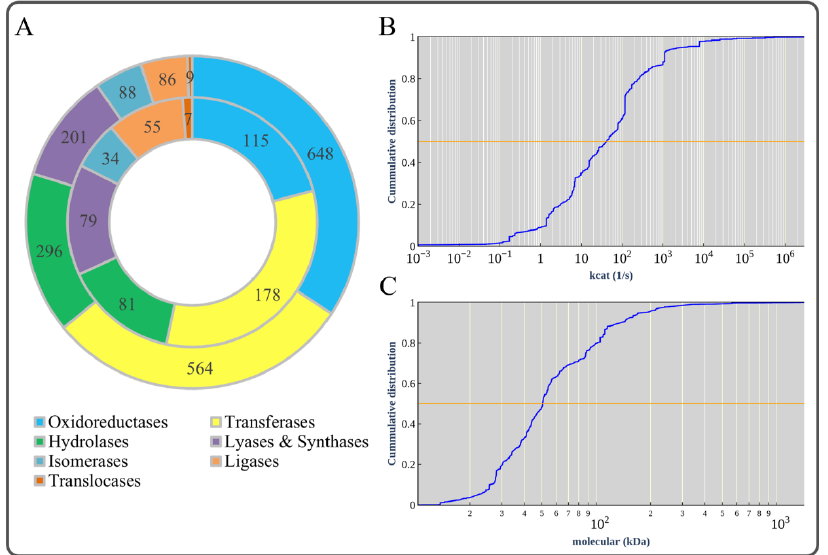
Figure 2. Basic information of ecBSU1. ( A ) Enzyme classification. The outer ring indicates that there were 1892 reactions with enzyme kinetic data, which can be divided into seven categories. The inner ring indicates that these reactions included 549 kinds of enzymes according to the corresponding EC numbers, which can also be divided into seven categories. ( B ) Cumulative distribution of k cat values. ( C ) Cumulative distribution of molecular weights.